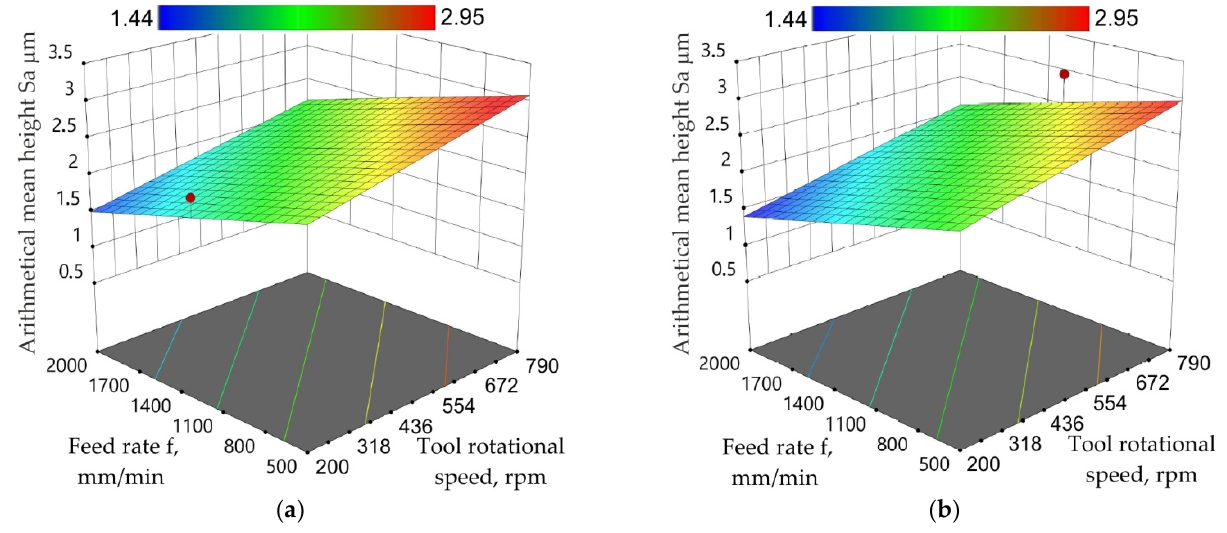
Figure 14. Response surface plots presenting the interaction between feed rate and tool rotational speed affecting the arithmetical mean height Sa measured on the inner side of the drawpiece for a p = 0.3 mm and toolpath ( a ) conventional and ( b ) climb strategies.